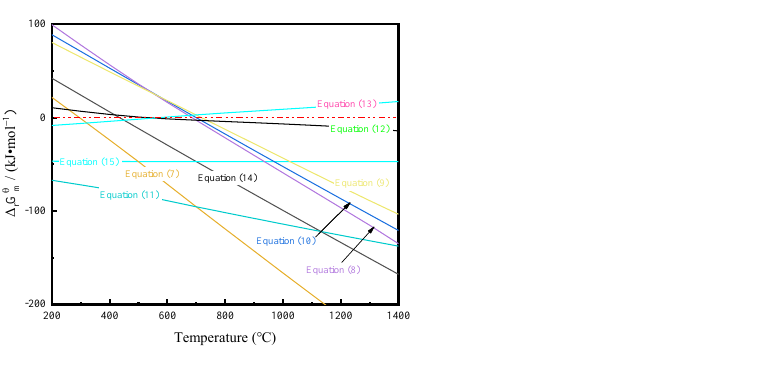
Figure 3. Gibbs free energy assessment as a function of temperature based on a fixed amount of reductive agent according to Equations (7) to (15).